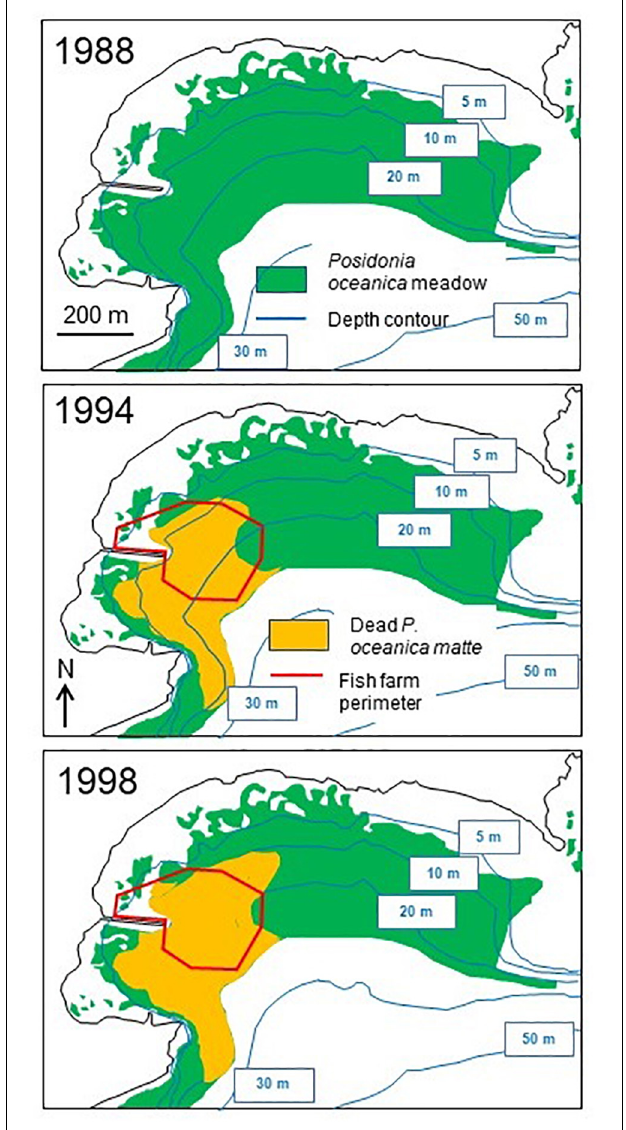
FIGURE 2 | Distribution of Posidonia oceanica meadow in 1988, 1994, and 1998 in El Hornillo Bay (Murcia, Spain). Only the complete mortality off (area of dead matte ) has been mapped. Original drawing, after Ruiz-Fernandez (2000) and Ruiz et al. (2001)